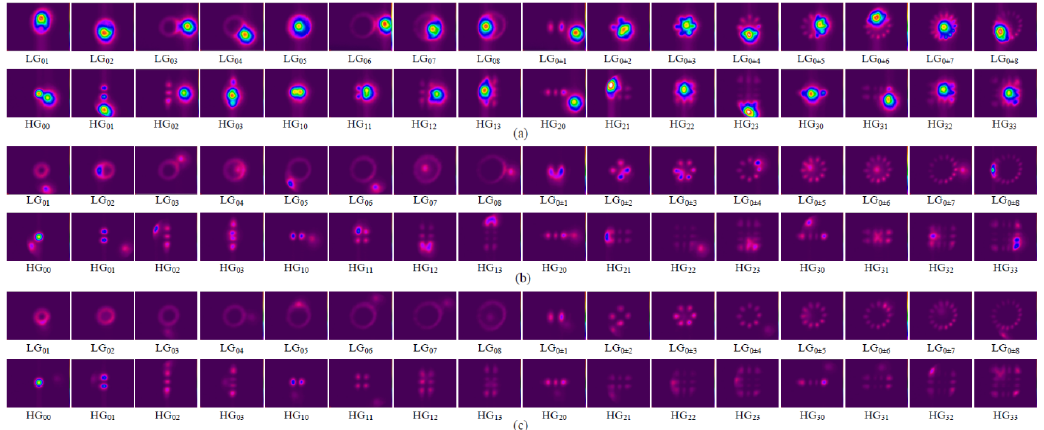
Figure 1. Experimentally generated beam profiles of: ( a ) LG, ( b ) Mux-LG, and ( c ) HG modes with no jamming interference. Reprinted from ref. [14].